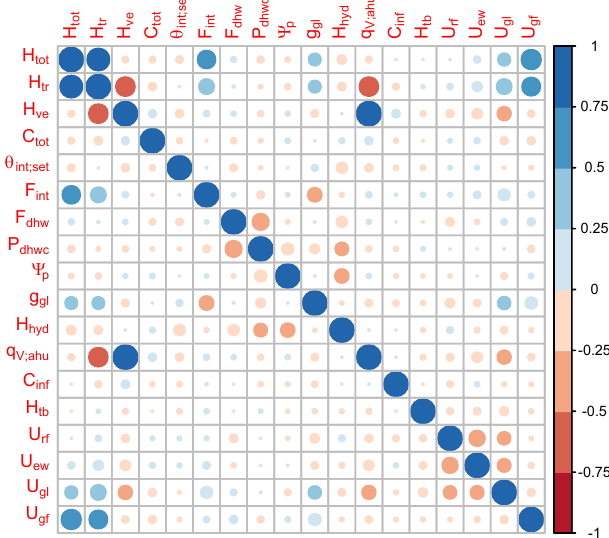
Figure 10. Parameter correlations based on the HMC samples: Color saturation and size of the circles indicate the magnitude of